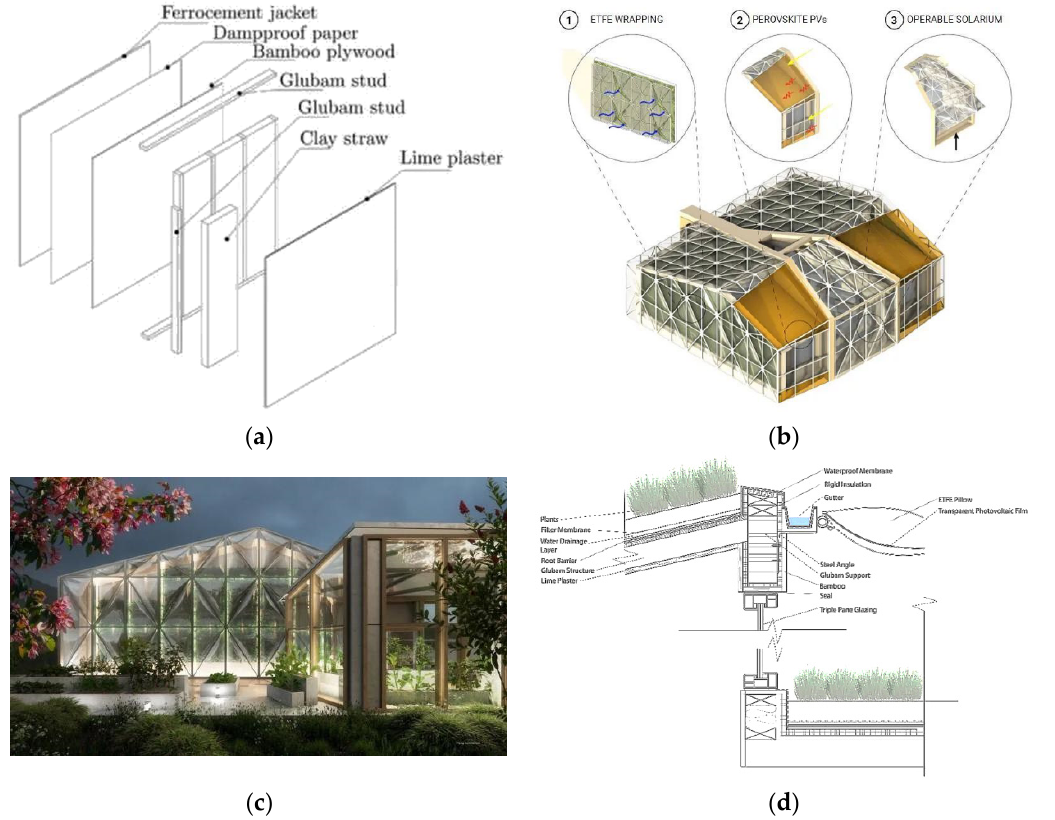
Figure 3. Main results of the Y-Project. ( a ) Bio-based structural system. ( b ) ETFE envelope. ( c ) Plant walls. ( d ) Greywater reclamation system.